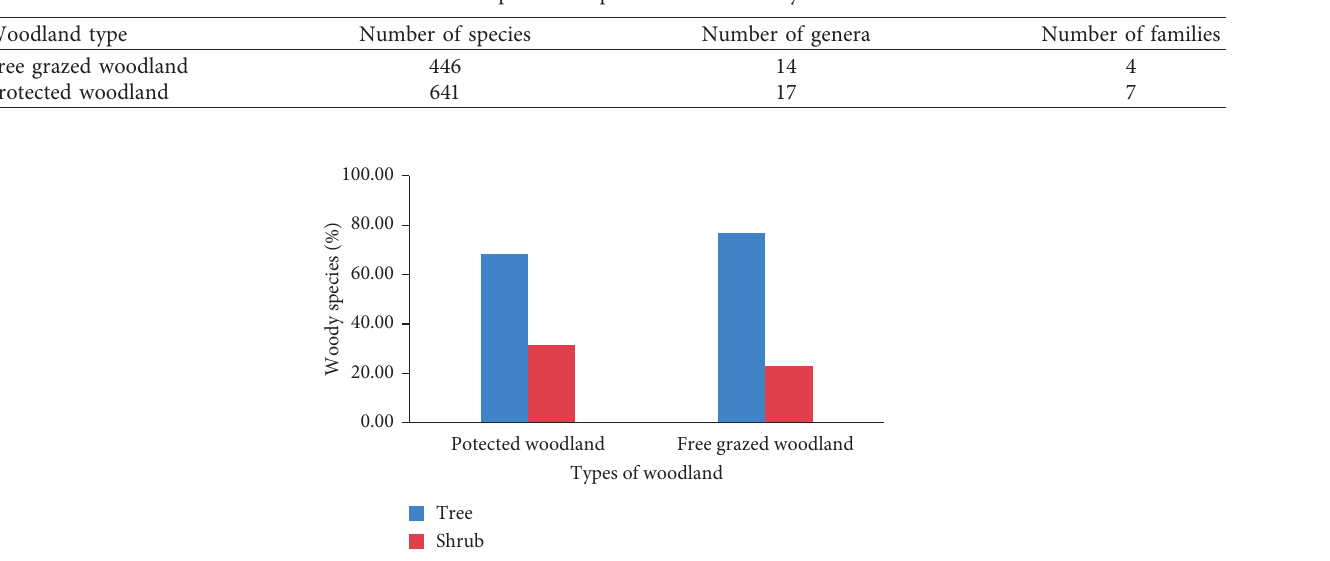
Table 1: Species composition and diversity.